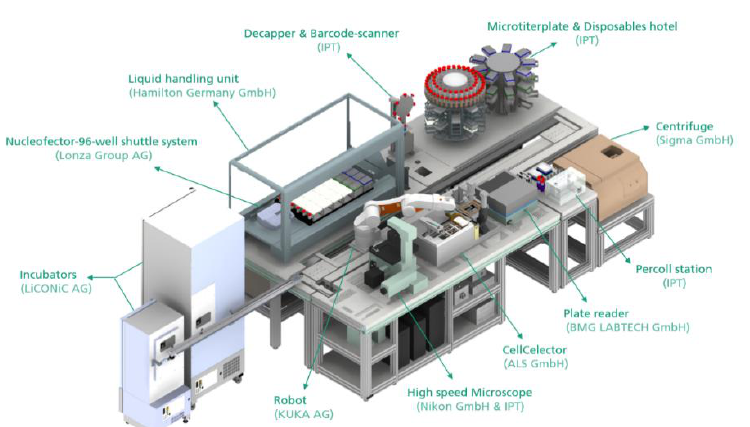
Figure 2. The StemCellFactory—a fully automated platform for the expansion of induced pluripotent stem cells (iPSC).